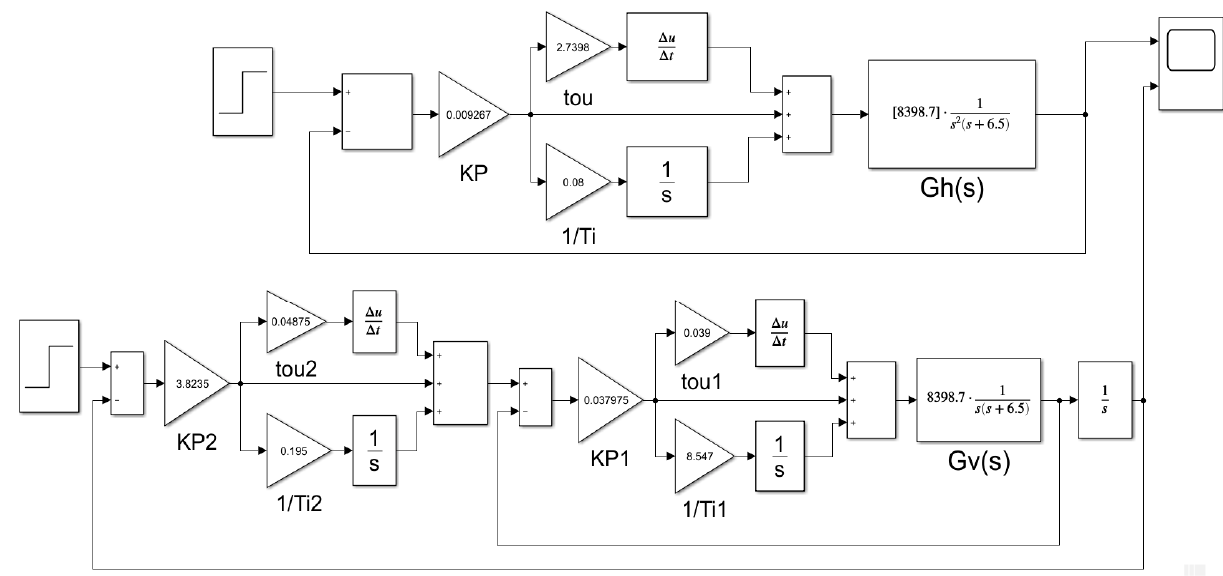
Figure 7. Simulink structure of the cascade PID for the height and velocity control.